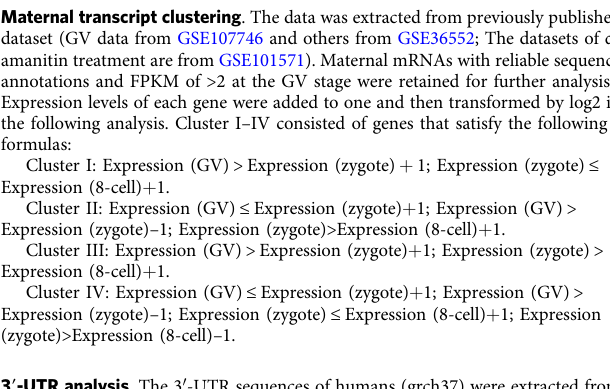
Maternal transcript clustering . The data was extracted from previously published dataset (GV data from GSE107746 and others from GSE36552; The datasets of α - amanitin treatment are from GSE101571). Maternal mRNAs with reliable sequence annotations and FPKM of >2 at the GV stage were retained for further analysis. Expression levels of each gene were added to one and then transformed by log2 in the following analysis. Cluster I – IV consisted of genes that satisfy the following formulas: Cluster I: Expression (GV)> Expression (zygote) + 1; Expression (zygote) ≤ Expression (8-cell) +